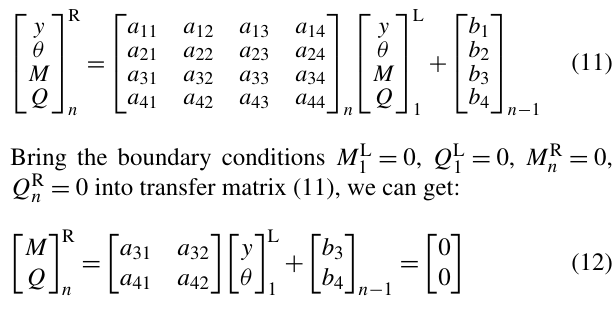
diameter and polar moment of inertia of the disc respectively. + R 2 J p = m j ( R 2 ) / 2, J d = J p / 2. R 1 is the inner diameter 1 j 2 j of the tilt disk. R 2 is the outer diameter of the tilt